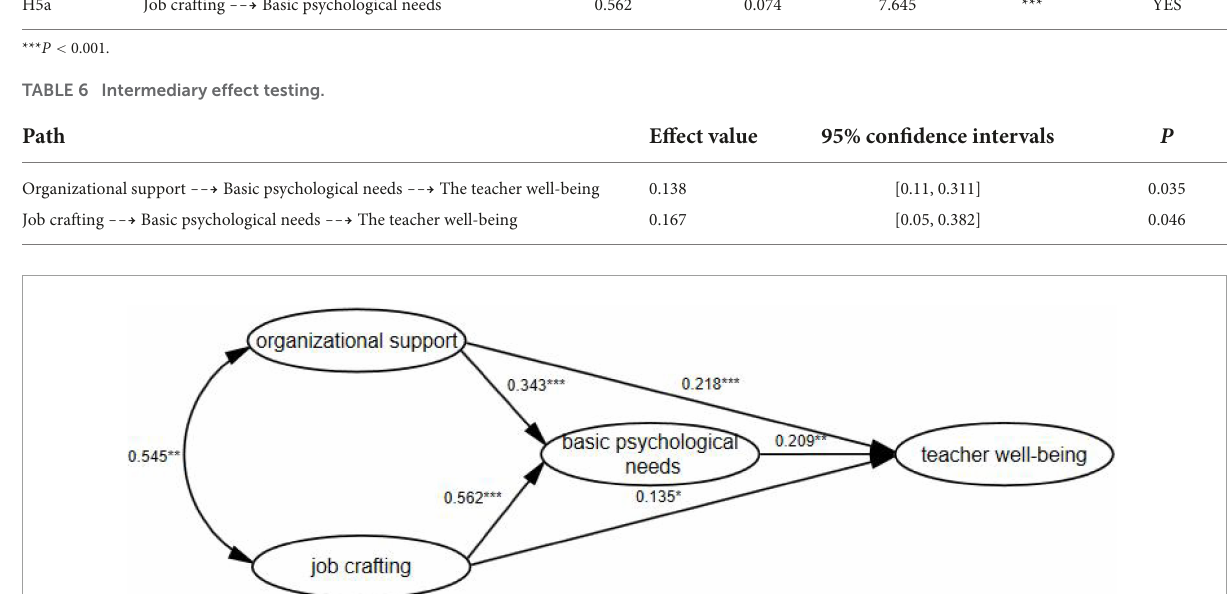
FIGURE2 The path relationships between the variables of organizational support, job crafting, basic psychological needs, and teachers well-being. * P < 0.05, ** P < 0.01, *** P <